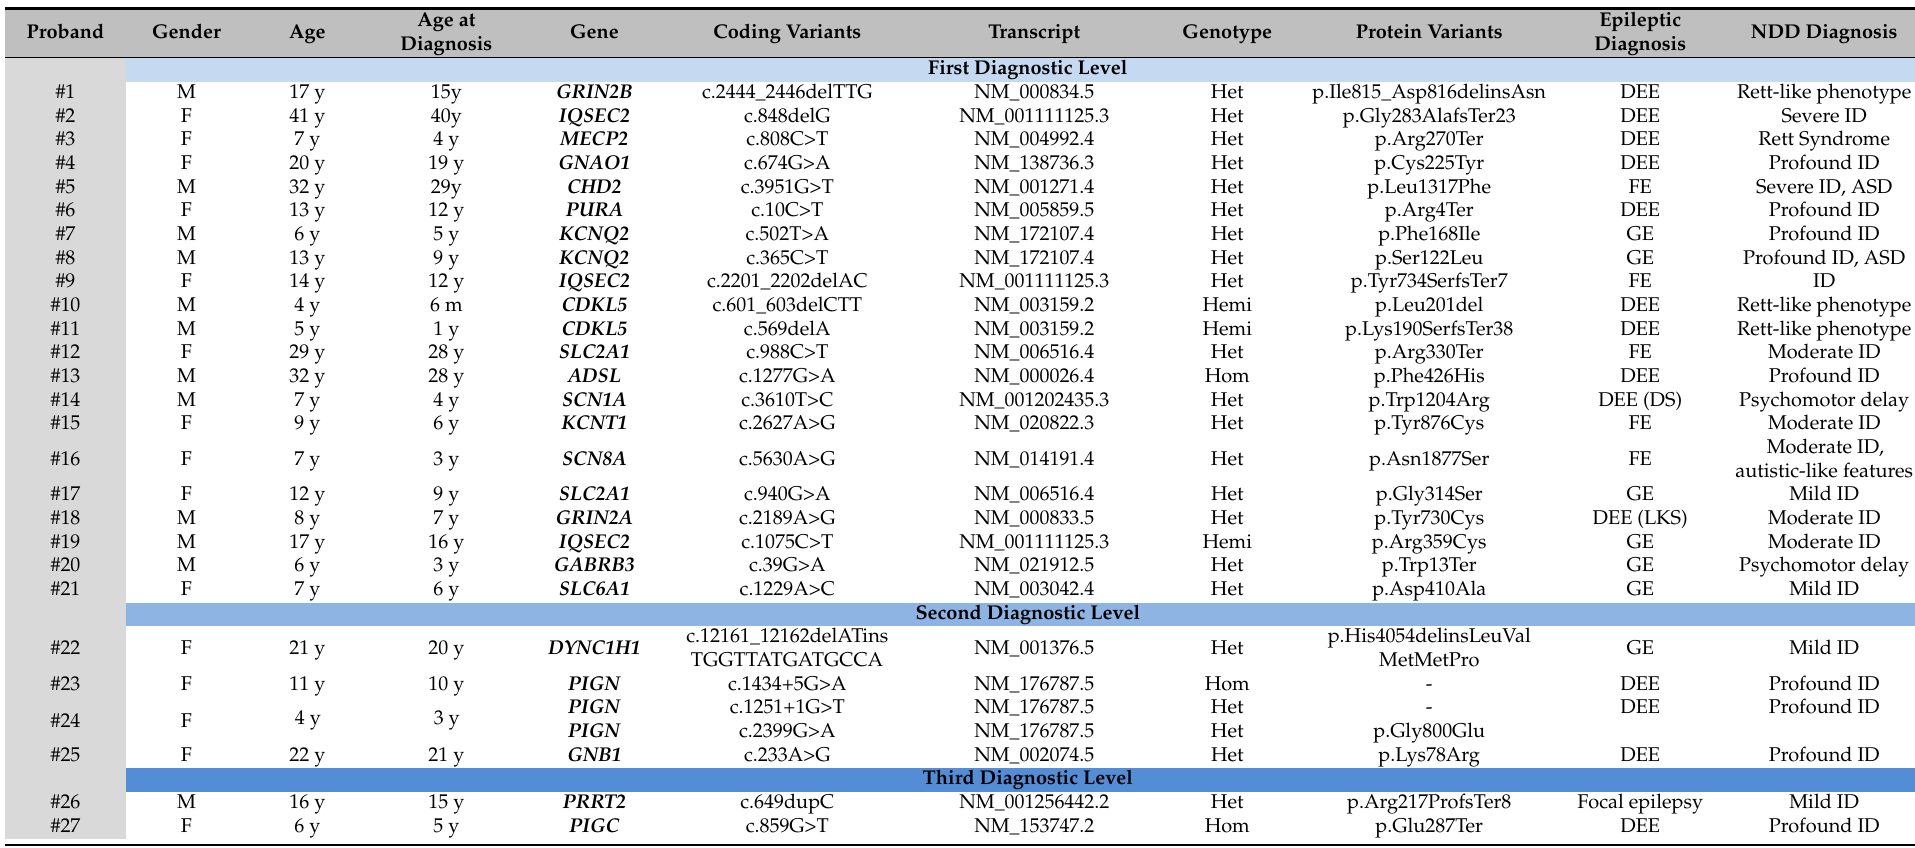
Table 1. Clinical, epileptological, and genetic characteristics of probands with pathogenic or likely pathogenic variants grouped based on diagnostic level. Abbreviations: ASD, autism spectrum disorder; DEE, developmental and epileptic encephalopathy; DS, Dravet Syndrome; LGS, Lennox-Gastaut Syndrome; LKS, Landau-Kleffner Syndrome; F, female; ID, intellectual disability; M, male; m, months; NDD, neurodevelopmental disorder; Y,